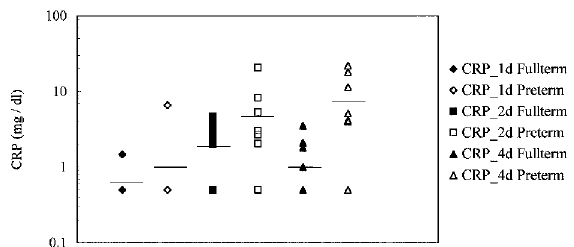
FIG. 2. Serial measurements of the CRP values at the first 4 days of full-term and pre-term neonates with infection. Horizontal lines represent the CRP mean values of each group on each day (1d, first day; 2d, second day; 4d, fourth day), filled symbols refer to the group of full-term infants, and open symbols refer to the group of premature